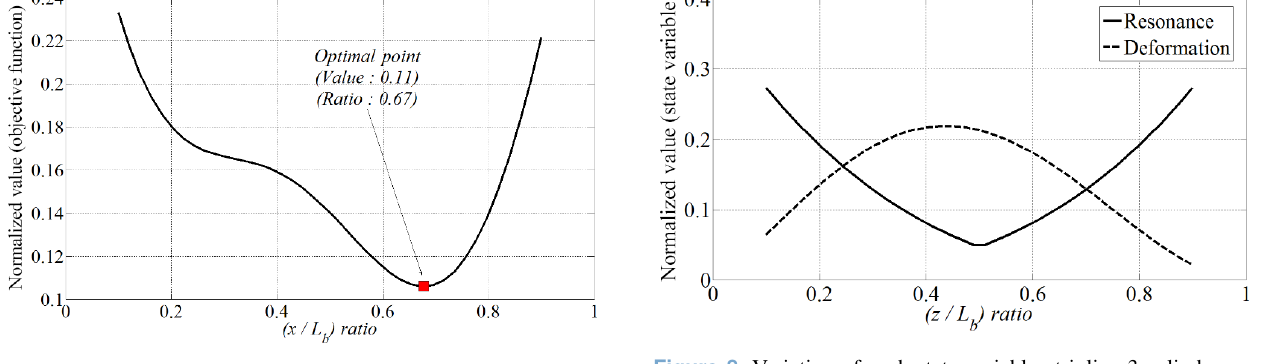
Figure 7. Variation of objective function at inline 4-cylinder en- gine.